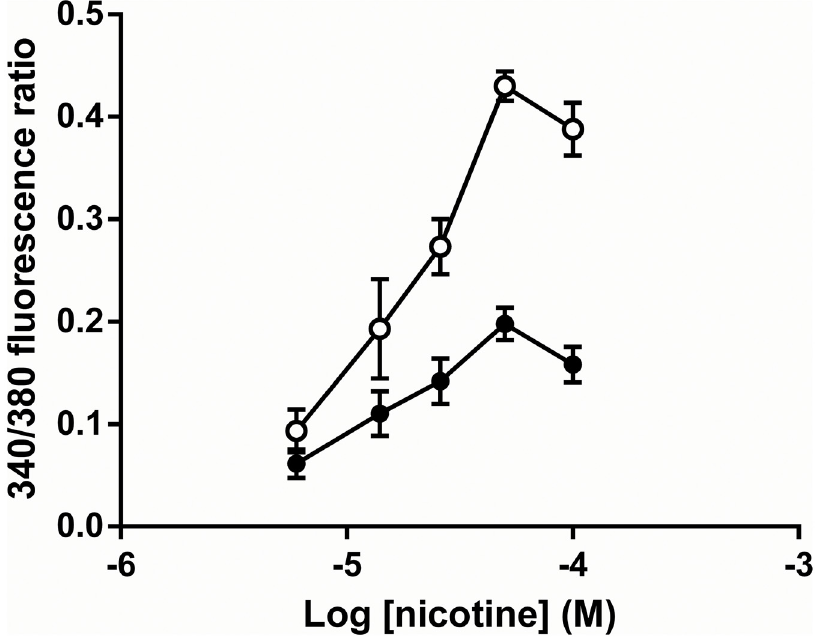
Fig 4. Concentration-response relationship for nicotine-evoked calcium responses in SH-SY5Y cells. The graph shows the inhibitory effect of the C10 bispyridinium compound MB779. Open circles, nicotine alone; closed circles, nicotine + MB 779 (2 μ M). Data are displayed as the mean ± SEM of two experiments with eight replicates on each plate.